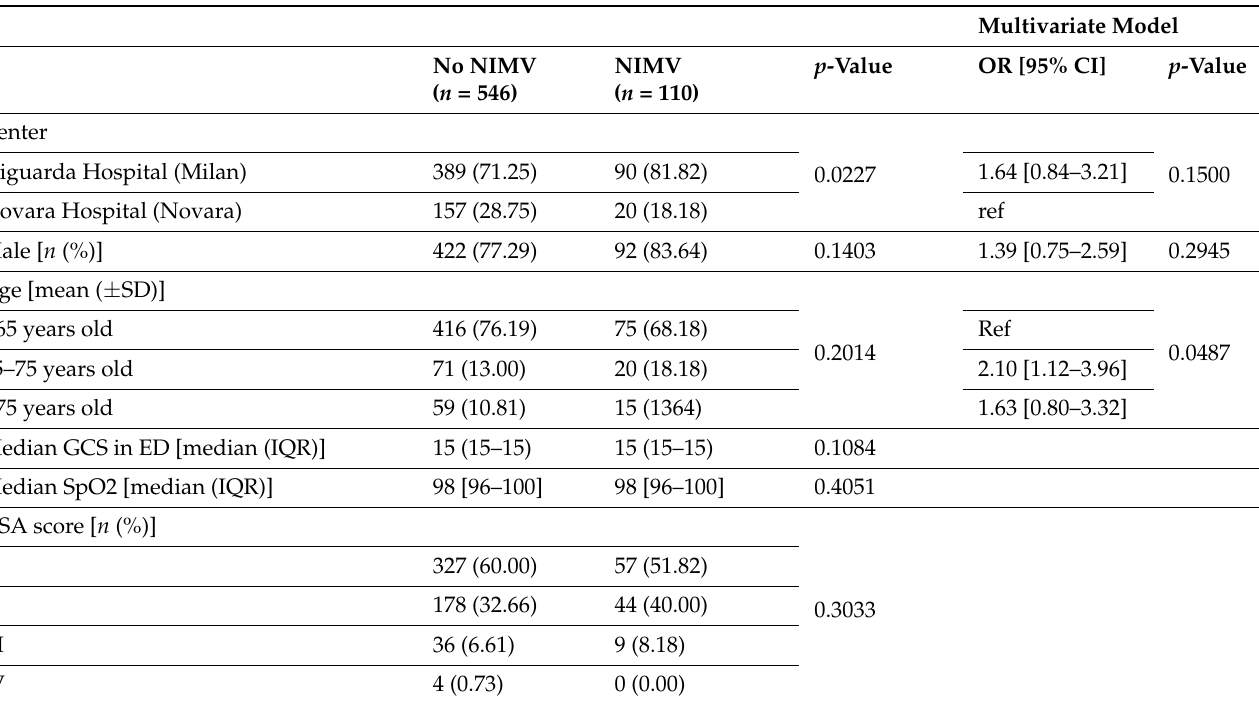
Table 3. Analysis of patients subjected or not subjected to